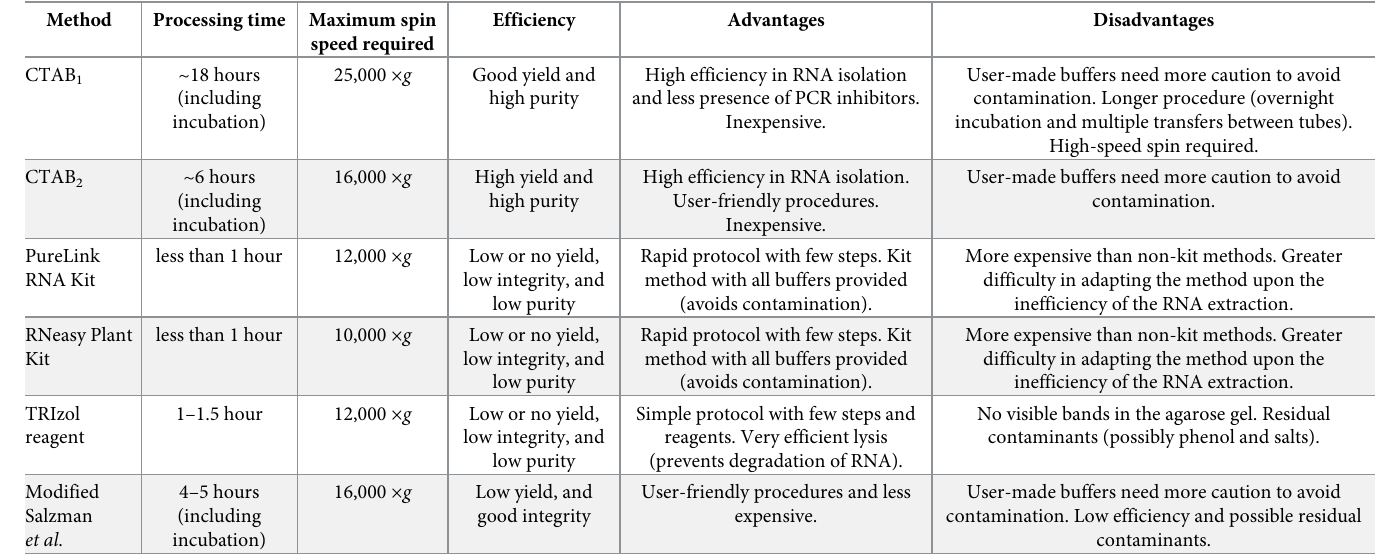
Table 2. Comparison of RNA extraction